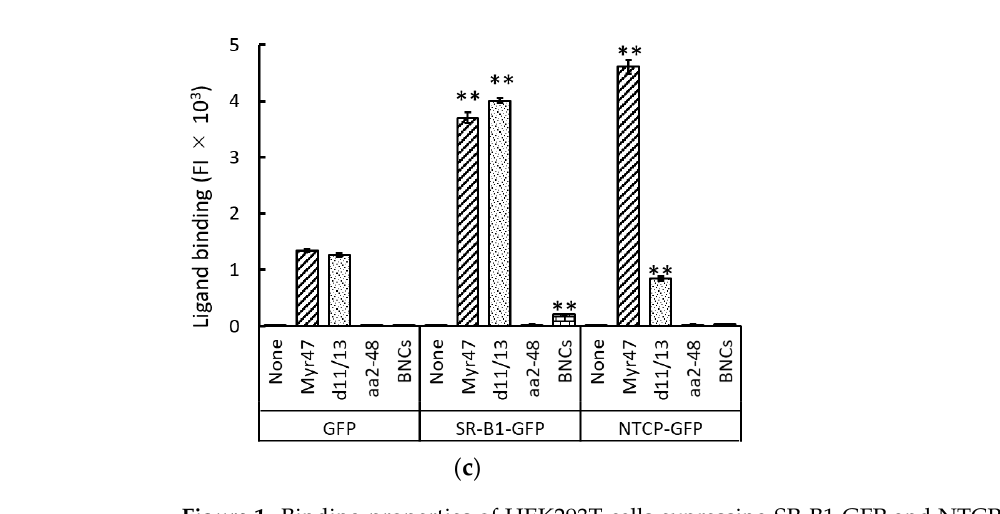
Figure 1. Binding properties of HEK293T cells expressing SR-B1-GFP and NTCP-GFP for Myr47, D-11/13, aa2-48, and BNCs. GFP, SR-B1-GFP, and NTCP-GFP were transiently expressed in HEK293T cells, and the binding of the fluorescence-labeled ligands was examined. ( a ) Western blot to detect GFP, SR-B1-GFP, and NTCP-GFP proteins in HEK293T cells transfected with their expression plasmids. Cell lysates, which were prepared from cells transfected with or without plasmids, were subjected to SDS-PAGE (5 μg protein/lane), and the Western blot analyses were carried out. SR-B1, GFP, NTCP, and GAPDH protein bands were detected using corresponding antibodies, which are indicated in the pictures. The same PVDF filter was repeatedly used for antibody binding after stripping antibodies previously bound to the filter. Symbols *, †, ‡, and § correspond to major bands of SR-B1, SR-B1-GFP, GFP, and NTCP-GFP proteins, respectively. ( b ) Two-parameter dot plot analyses of ligand binding to GFP, SR-B1-GFP, and NTCP-GFP using flow cytometry. HEK293T cells transfected with or without indicated expression plasmids were examined as to whether various fluorescence-labeled ligands bind to them. To obtain these plots, 30,000 cells of each sample were subjected to the analysis. Vertical and horizontal axes of plots show FI of GFP and ligands with flow cytometric channels used for the analyses, respectively. ( c ) Quantified ligand binding of HEK293T cells expressing GFP, SR-B1-GFP, and NTCP-GFP. Ligand binding of the upper gated area (GFP + ) in each two-parameter dot plot ( a ) was quantified. Data are expressed as means and standard errors (vertical bars) in triplicate assays. To obtain these data, 10,000 cells were analyzed. Statistical analysis was carried out using Student’s t -test; ** indicates p < 0.01 when two values were compared between the GFP + subsets of cells expressing GFP and SR-B1-GFP or NTCP-GFP.